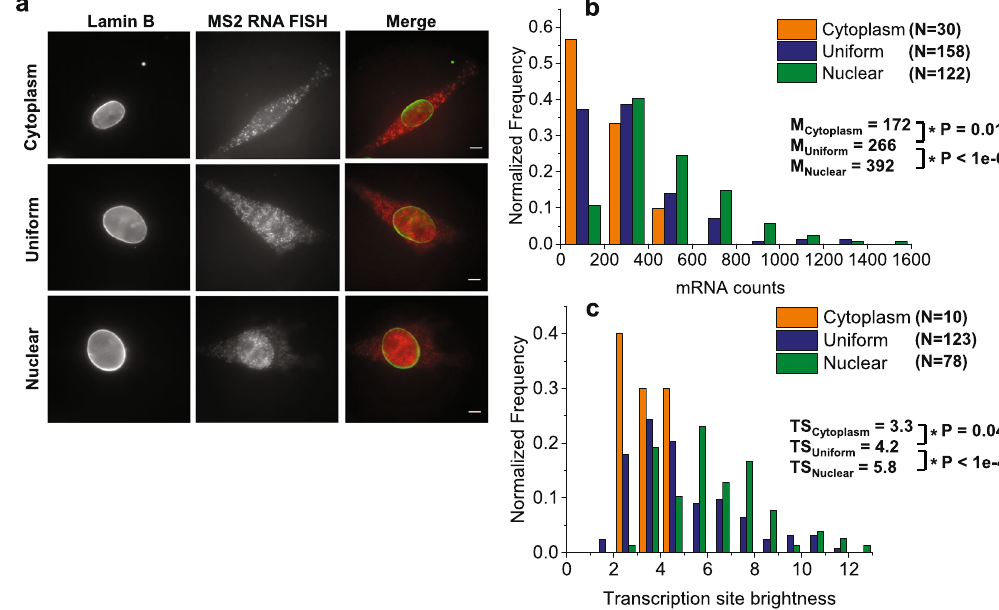
Figure 5. Distinct subcellular localizations of Luc - MS2 mRNA correlate with Ccnb1 promoter activities. ( a ) Representative single molecule RNA FISH images for Luc - MS2 mRNA (red) and anti-Lamin B immunofluorescence (green) in asynchronous Ccnb1 :: Luc - MS2 (clone 96) cells. Merged images are shown on the right. Cells display cytoplasmic, uniform or nuclear localization of Luc - MS2 mRNA. Scale bars: 5 µ m. ( b , c ) Histograms and medians of mRNA counts ( b ) and TS brightness ( c ) of the Ccnb1 :: Luc - MS2 transgene among cells exhibiting distinct subcellular mRNA localizations. Measured cell numbers and TS numbers are shown in the plots. Asterisks ( * ) indicate statistically significant differences determined by student’s t-test (P values are shown in the plots). FISH images from three experiments were